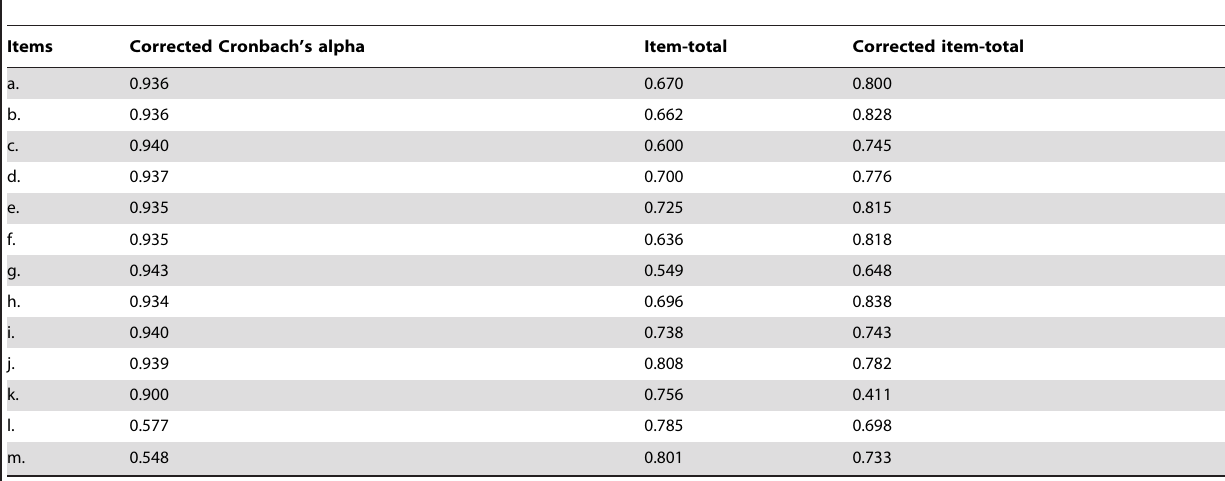
Table 2. Internal consistency and item analysis of FN and